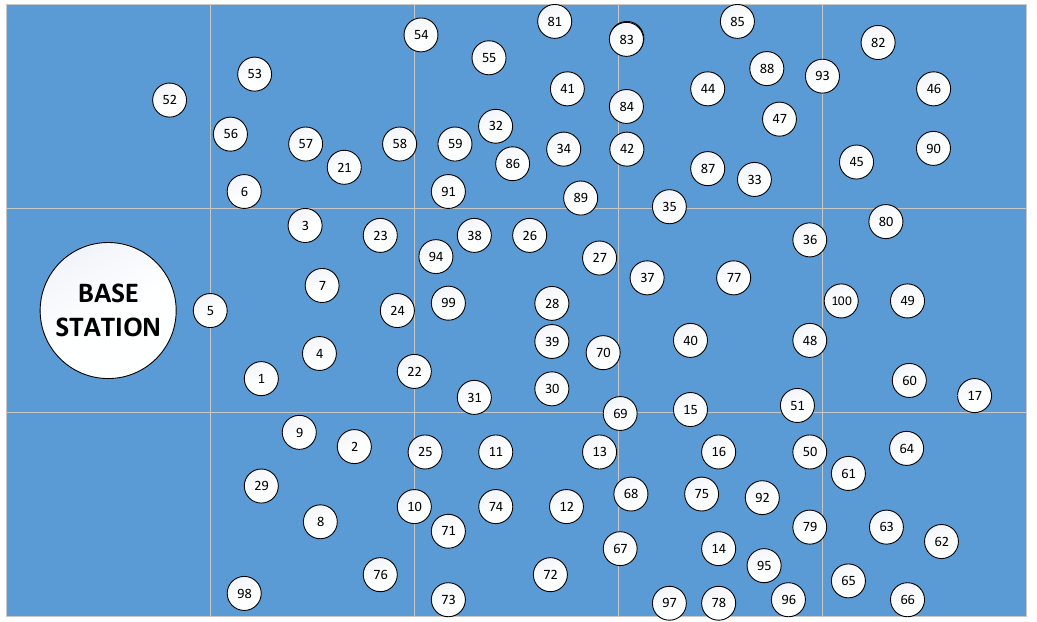
Figure 9. First view of the network.